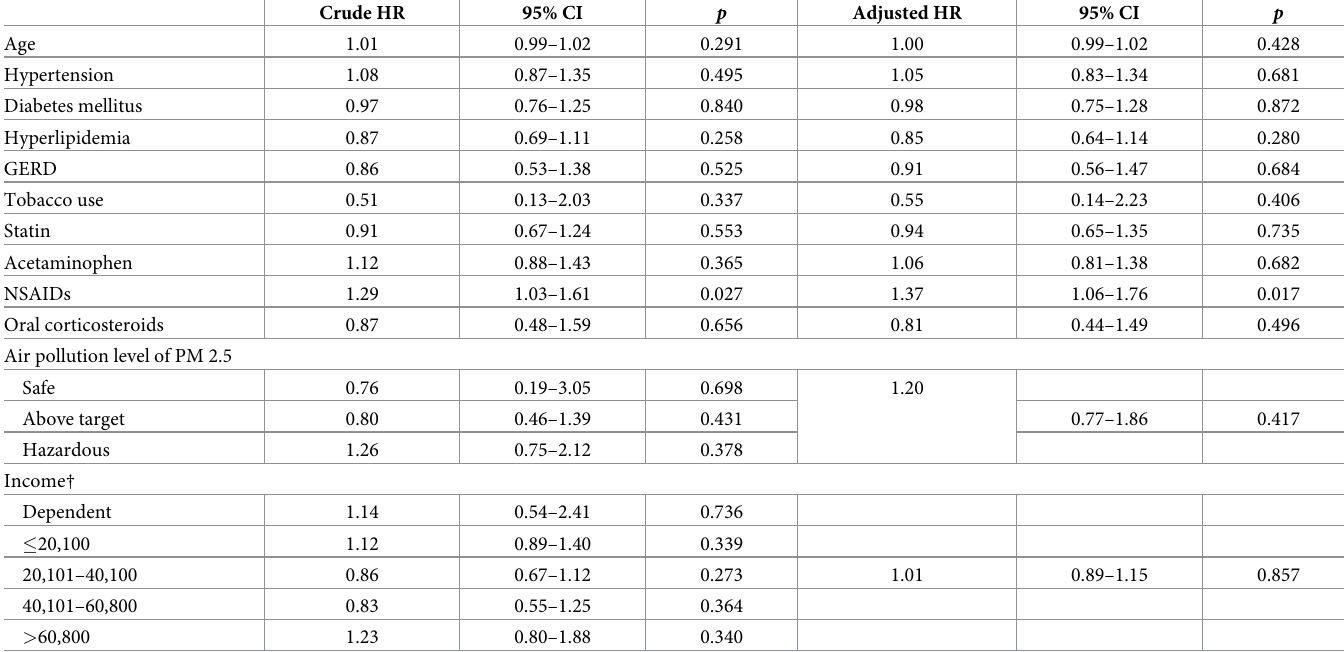
Table 3. Multivariate analysis of the potential risk factors of atopic